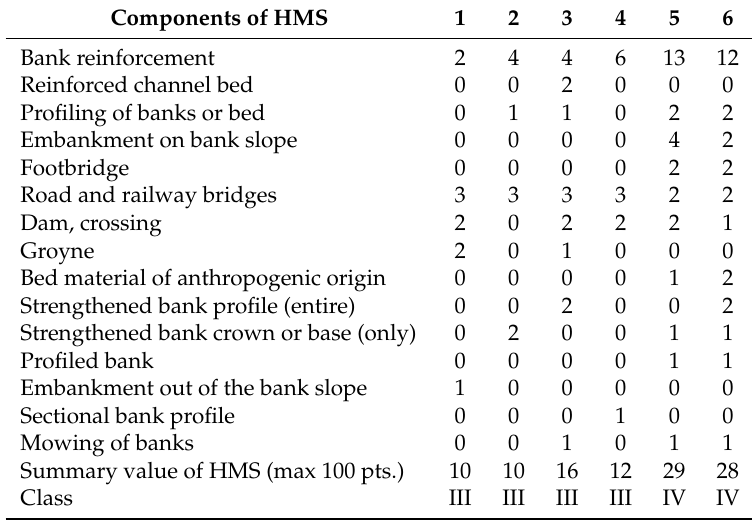
Table 7. Component and average values of the habitat transformation index (HMS) above and below the hydropower plants on the rivers Bystrzyca, ´ Sl˛eza, and